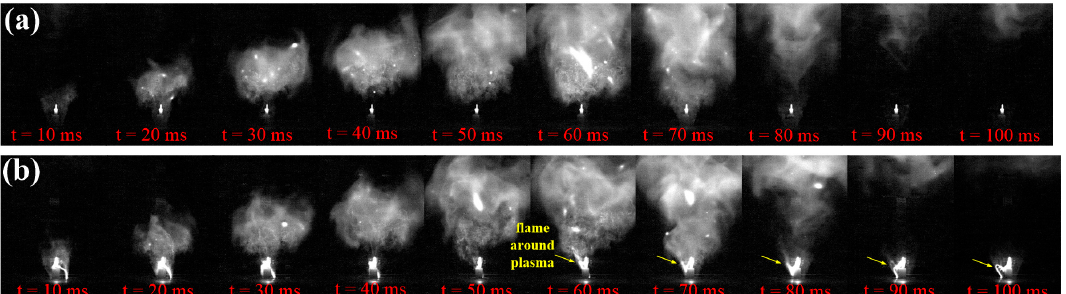
Figure 15. ( a ) The dynamic process of swirl flame in pulsating air flow mode; ( b ) the dynamic process